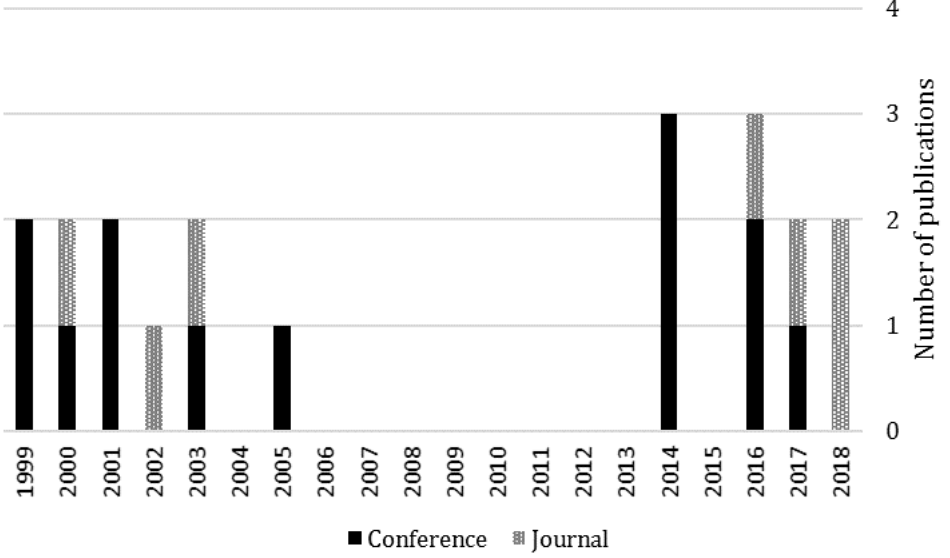
Figure 4. The number of published articles per year and by type of publication in the area of non-energy benefits in industry.